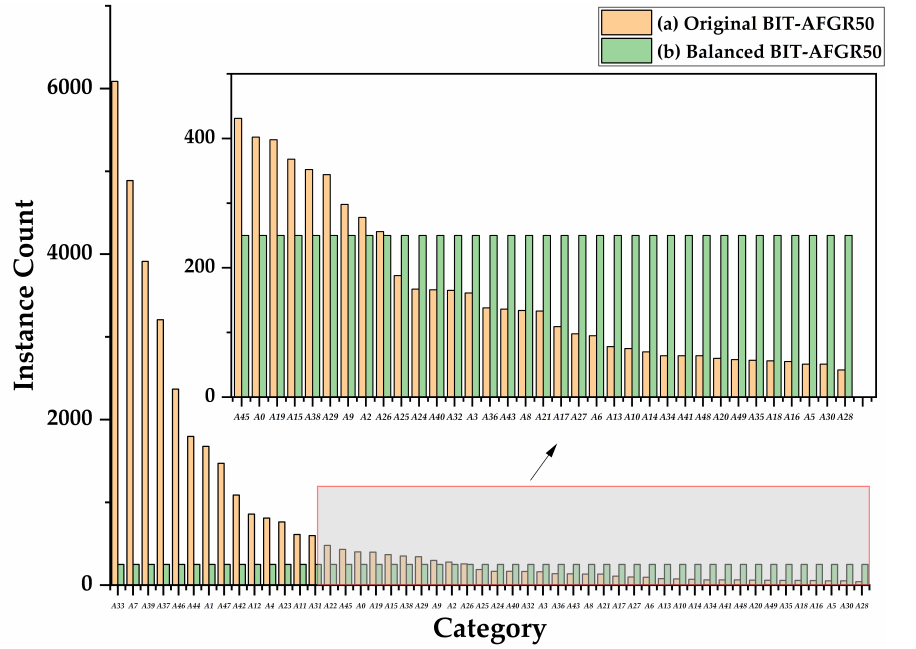
Figure 6. Instance count distribution in original and balanced BIT-AFGR50.